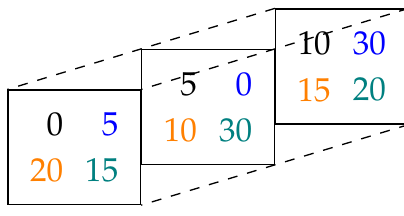
Figure 1. A sample 3D data grid.